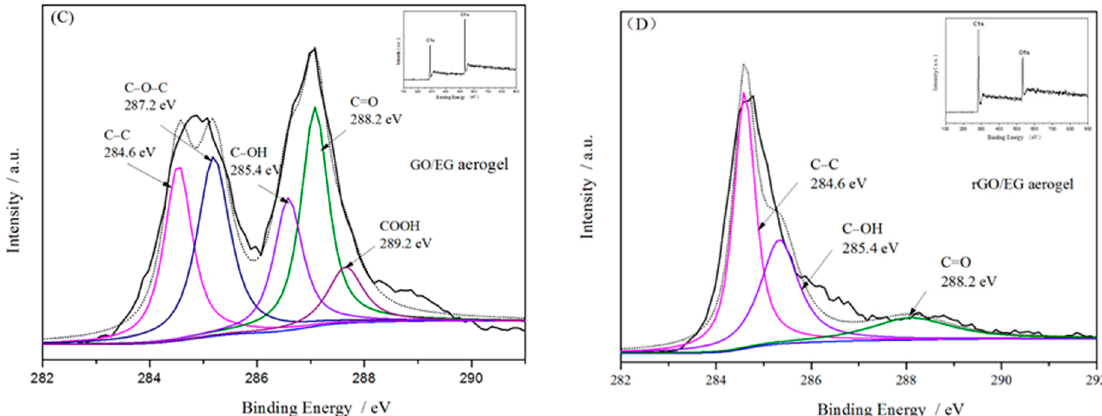
Figure 4. FTIR spectra of GO/EG aerogel and rGO/EG aerogel ( A ), Raman spectra of expanded graphite (EG), graphene oxide (GO), GO/EG aerogel and rGO/EG aerogel ( B ), XPS of GO/EG aerogel and rGO/EG aerogel ( C , D ), The upper right corner picture shows the ratio of carbon to oxygen of GO/EG aerogel and rGO/EG aerogel ( C , D ).